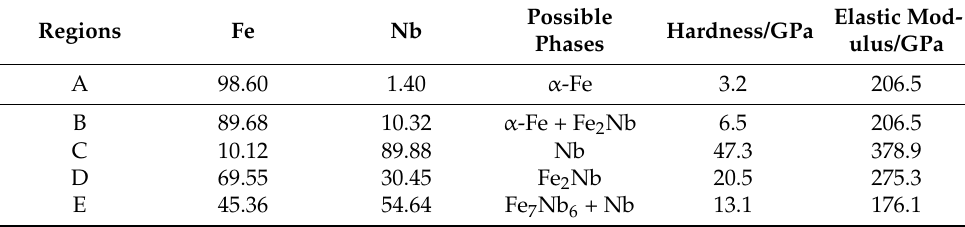
Figure 3. Microstructure in the Fe–Nb weld metal: ( a ) low magnification image at the Q235 BM/Nb WM interface; ( b – d ) the enlarged views of rectangles in ( a ); ( e , f ) the corresponding EBSD phase maps (superimposed with band contrast images) of ( c , d ), respectively; ( g ) the microstructure in the center of Nb weld metal. Table 2. Chemical compositions of typical phases in Nb weld metal (at.